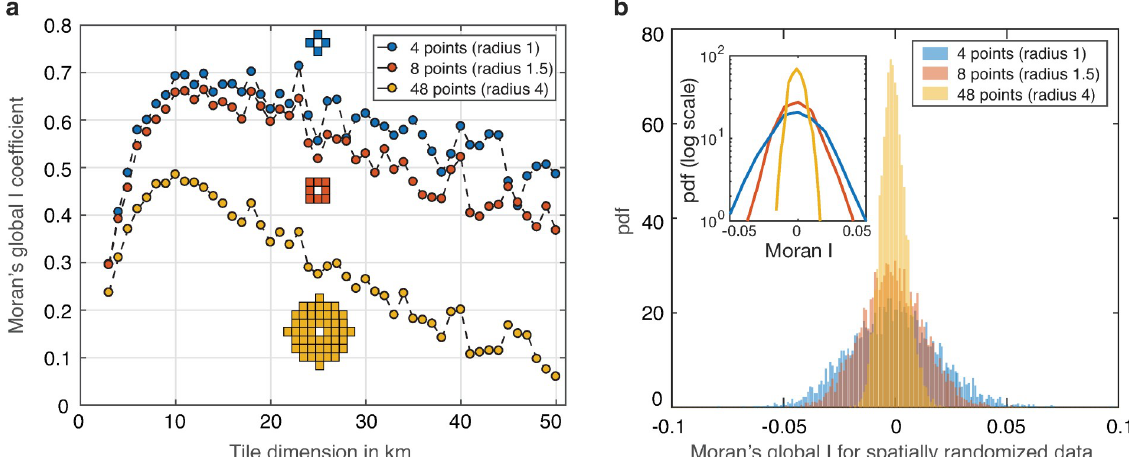
Fig 2. Spatial correlation of Round 1 positivity. a Moran’s I statistics plotted against the dimension of the square tiles covering the area of Slovakia. For each tile dimension Moran’s I values for three alternative weight functions are displayed, see Methods. b Distribution of Moran’s I for randomly reshuffled data (4999 permutations) for the three weight functions and tile dimension 10 km. The distributions on a logarithmic scale are shown in the inset.